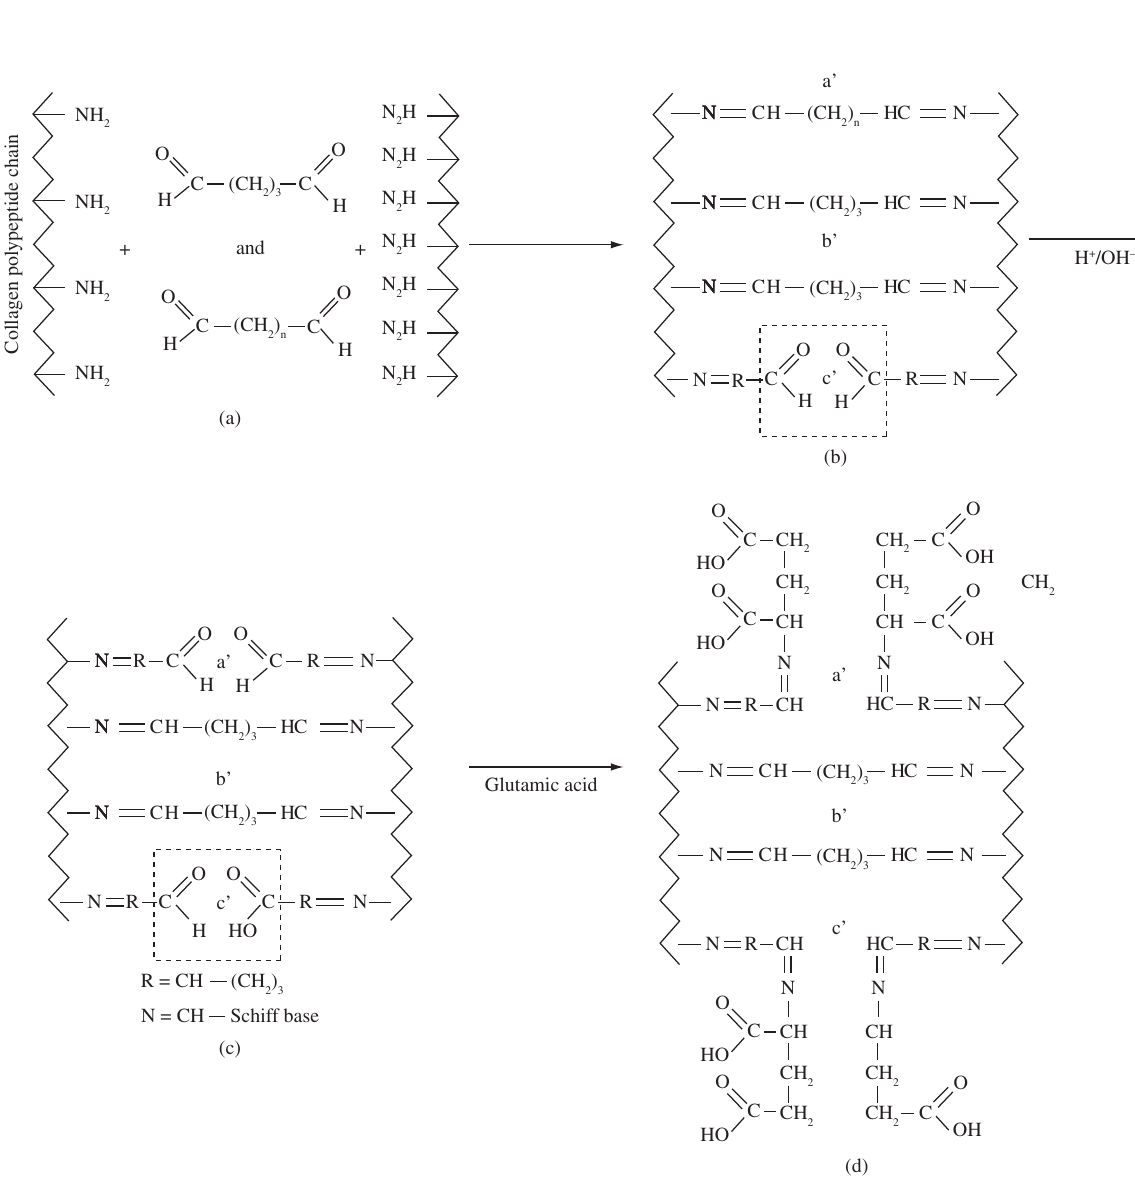
Figure 2. Schematic representation of the reaction glutaraldehyde (GA) solutions a) with natural tissues leading to b) desirable monomeric GA type of crosslinks a’) polymeric GA crosslinks in red; b’) bivalent monomeric glutaraldehyde type of crosslink; and c’) residual free aldehyde groups from incomplete initial GA reaction or resulting from the c) depolymerization process and d) its neutralization by glutamic